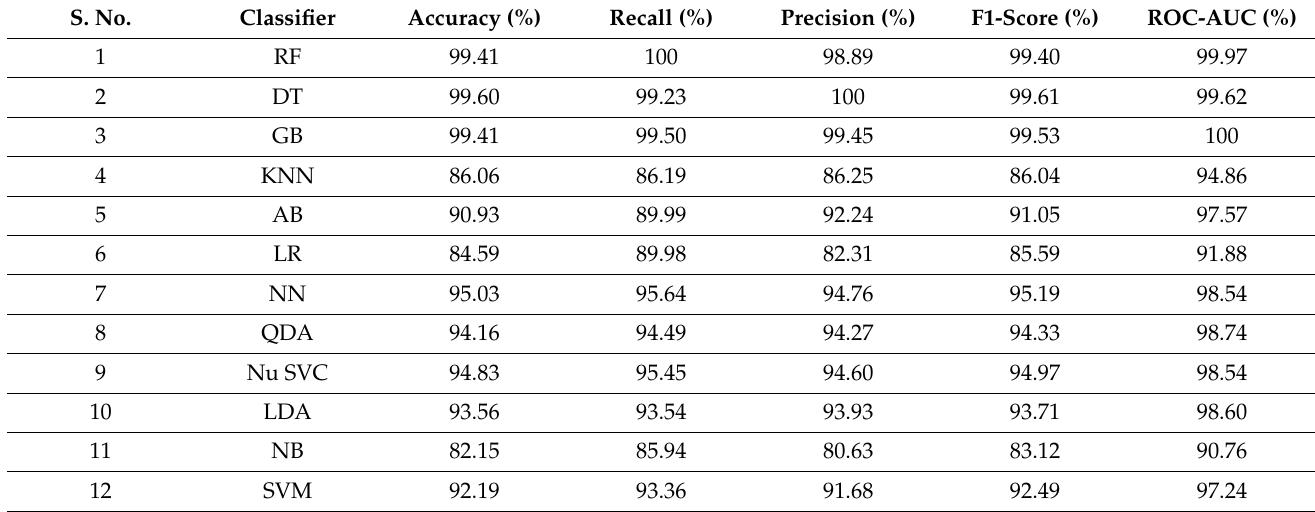
Figure 15. Performance of ML classifier using StakingCV Classifier. Table 3. Performance of ML classifier using 5-fold cross-validation.